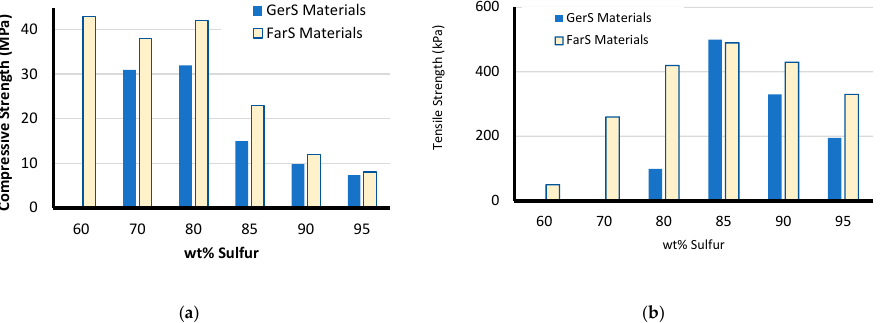
Figure 3. Comparison of ( a ) compressive strength and ( b ) tensile strength as a function of terpenoid identity and monomer feed composition. Table 2. Mechanical properties of terpenoid-sulfur composites.